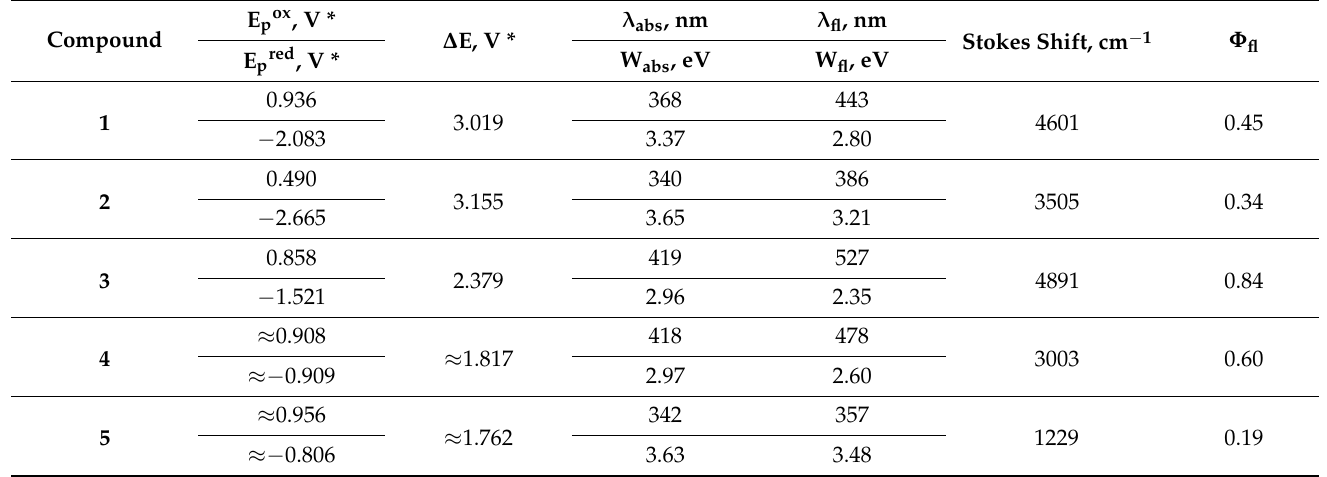
Table 1. Peak potentials for the oxidation and reduction of 1 – 5 , absorption and fluorescence maxima in DMF, Stokes shifts, and quantum